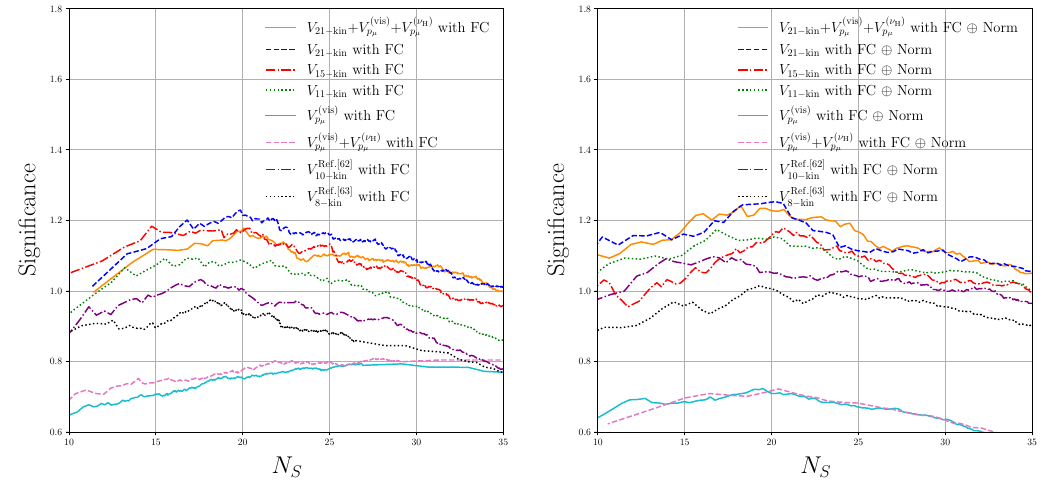
Figure 3 . Significance of observing double Higgs production at the HL-LHC with L = 3 ab − 1 for DNNs with bare inputs (left) and DNNs with normalized inputs (right).